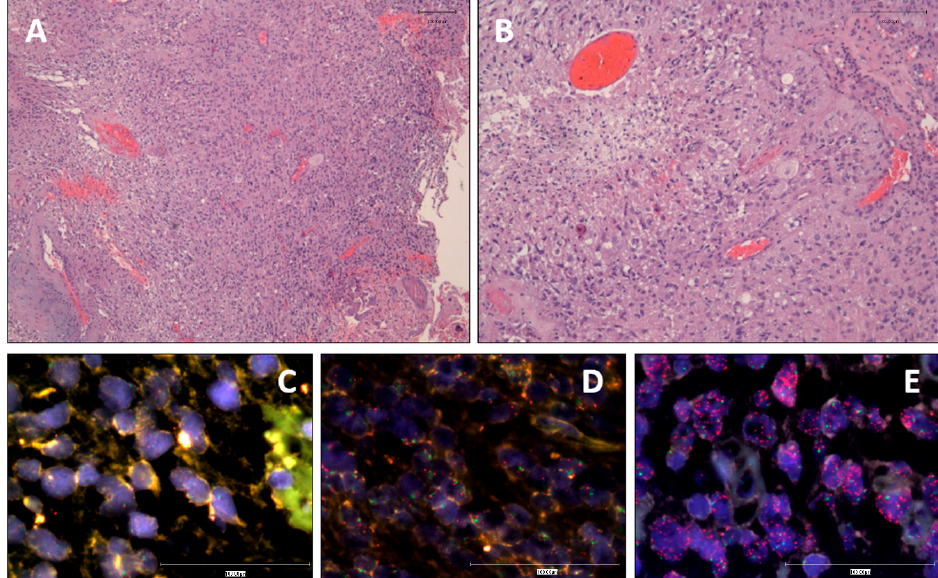
Figure 1. Representative microphotographs of GB, IDH- wt. ( A ) High cellularity and poor differentiation with prominent microvascular proliferation and necrosis (Hematoxilin and Eosin, 10 × ). ( B ) Highly anaplastic, heterogeneous cells and microvascular proliferation (Hematoxilin and Eosin, 20 × ). ( C – E ) iFISH microphotographs showing the status of EGFR by an orange LSI-EGFR probe and the centromere of chromosome 7 as a reference, stained by CEP-7 green probe in cases representing the tree levels of amplification. ( C ) No EGFR amplification (40 × ). ( D ) Low level of EGFR amplification (40 × ). ( E ) High EGFR amplification (40 × ).